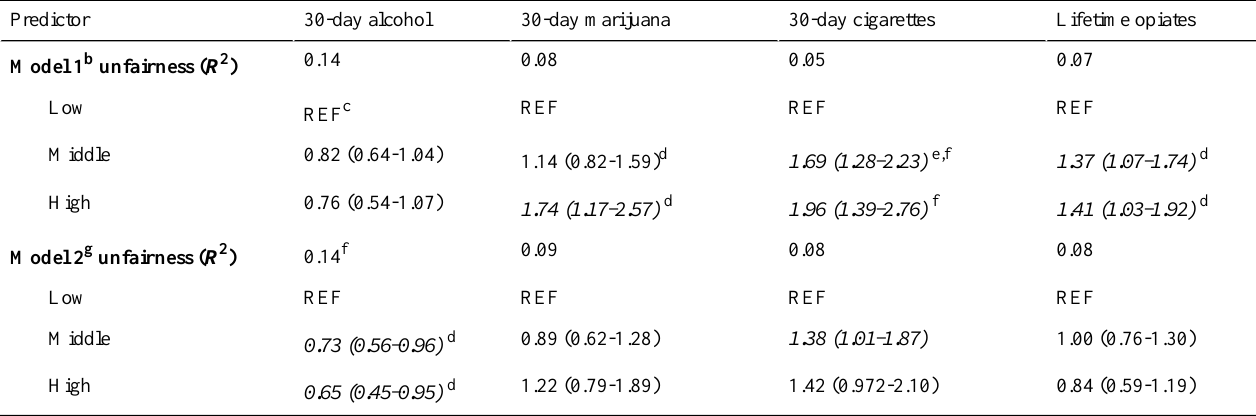
Table 5. Adjusted odds of self-reported substance use by unfairness a